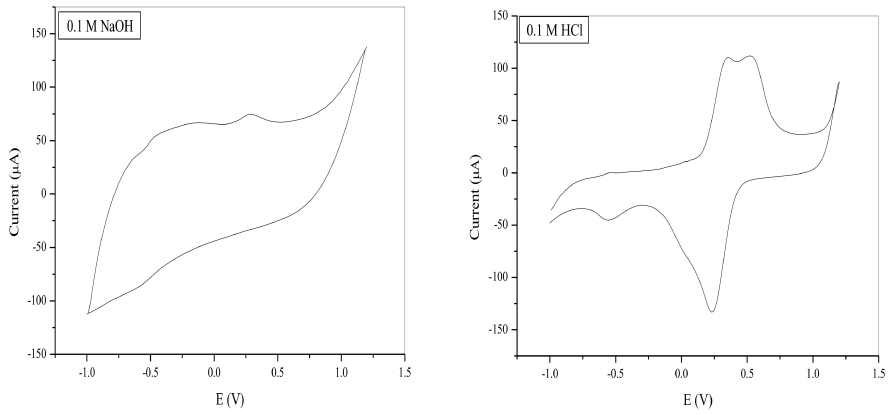
Figure 7. CV of the 0.1 M supporting electrolyte at the SPCE/OPE/LBIONPs, (scan rate = 0.1 V/s, Potentials vs. Ag/AgCl).